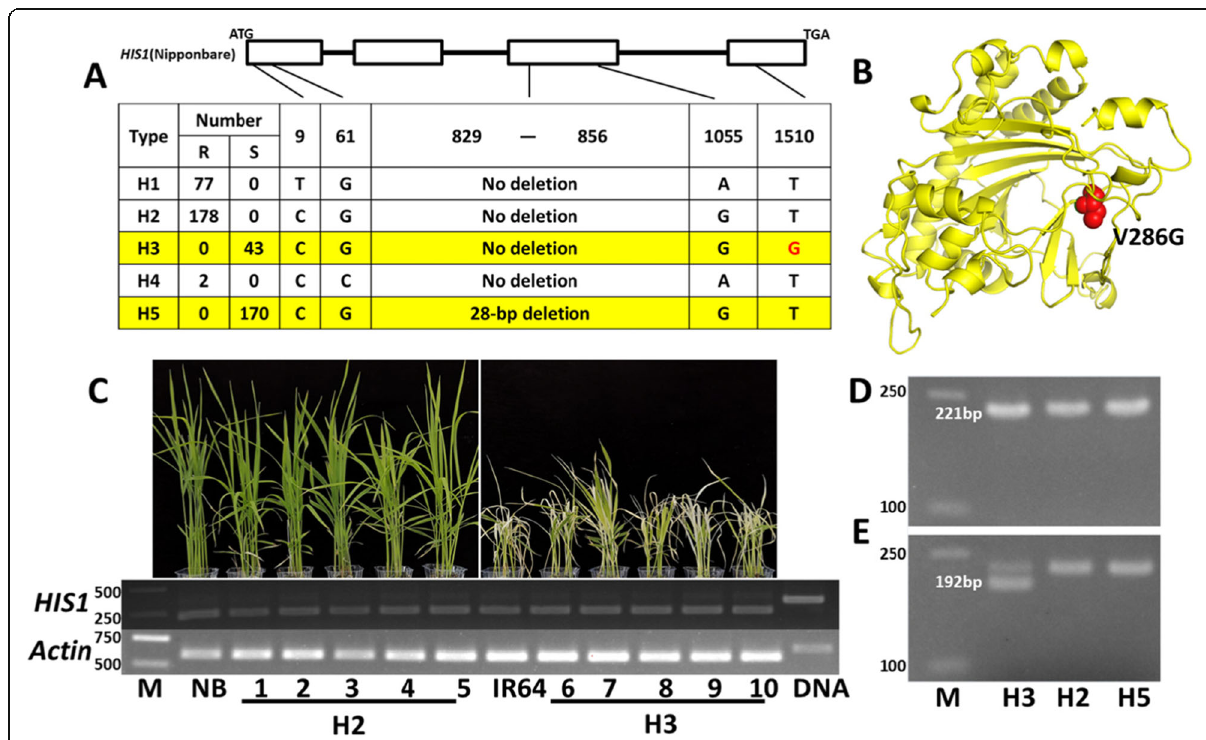
Fig. 2 T1510G mutation leads to the loss of function of HIS1. a Different haplotypes of HIS1 in the 493 indica rice accessions. R, highly resistant to BBC without moderate resistance. S, highly susceptible to BBC without moderate susceptibility. b Three-dimensional structure model of HIS1 and the location of the V286G (T1510G) mutation (red). c RNA expression of HIS1 in some accessions harboring H2 and H3. 1, Nongxiang32; 2, Guichao2hao; 3, Shuhui257; 4, Minghui70; 5, Youzhan; 6, Xianhui207; 7, IR50; 8, Aizaizhan; 9, Xiangwanxian6hao; 10, R898; DNA, Nipponbare genomic DNA. d , e dCAPS marker designed for the T1510G mutation. d and e represent the PCR products before and after treatment with the restriction enzyme Dde1 . M, DNA